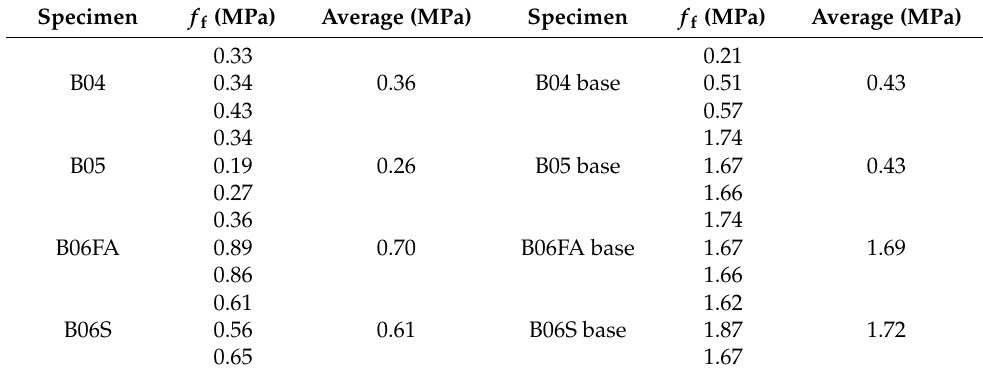
Table 13. Test result of flexural strength of AAC and the base material.